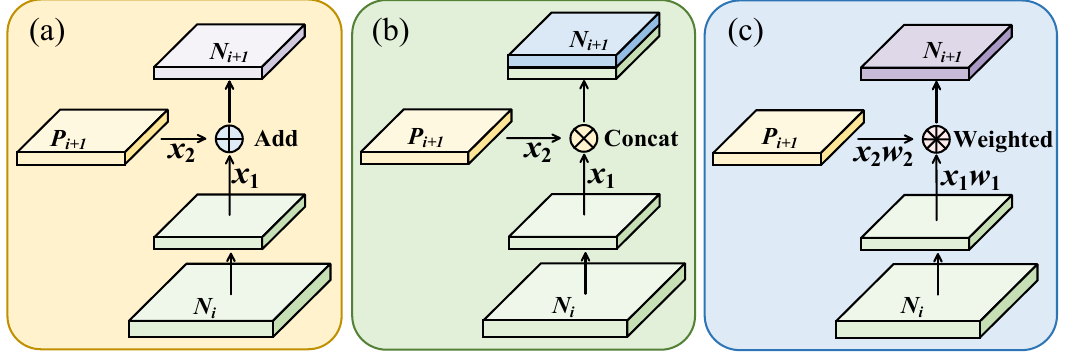
Figure 7. Comparison of feature fusion methods: ( a ) PANet; ( b ) YOLOv5; ( c ) ours.